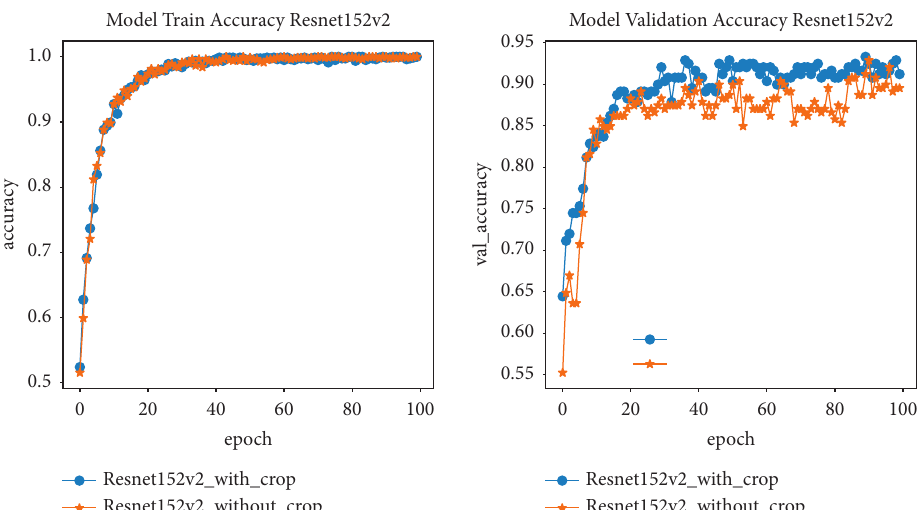
Figure 7: Accuracy of ResNet152V2 network architecture before and after